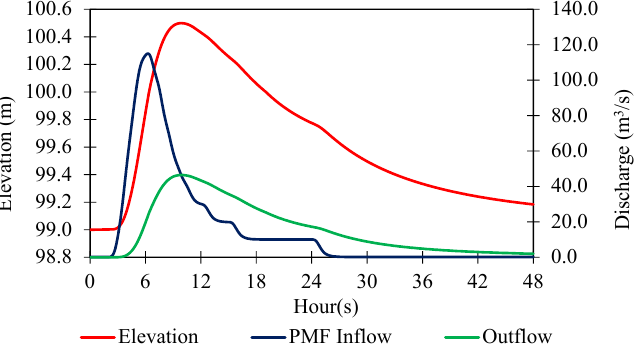
Figure 12. Reservoir water elevation, and PMF inflow and outflow discharges after the reservoir routing calculation.